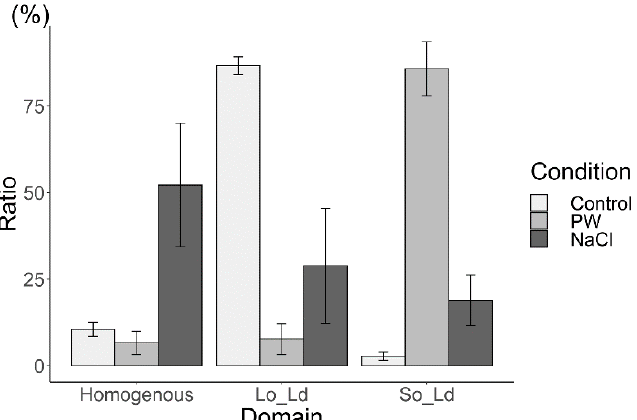
Figure 4. The percentages of phase-separated structures (homogenous, Lo/Ld, and So/Ld in DPPC:DOPC:Chol (40:40:20), Control, bright grey); DPPG:DPPC:DOPC:Chol (15:25:40:20), made in pure water (PW, grey)); and DPPG:DPPC:DOPC:Chol (15:25:40:20) made in a 10 mM sodium chloride solution (NaCl, dark grey), respectively, performed at 20.0 ° C. Condition PW means the number ratio of homogeneous, Lo/Ld, So/Ld liposomes observed in pure water, and condition NaCl means those observed in a 10 mM NaCl solution. Each bar represents the average value of three samples; standard errors are shown as error bars. Abbreviations: DPPC, 1,2-dipalmitoyl- sn -glycero-3-phosphocholine; DOPC, 1,2-dioleoyl- sn -glycero-3-phosphocholine; DPPG, 1,2-dipalmitoyl- sn -glycero-3-phosphoglycerol; Chol, cholesterol; Lo/Ld, liquid-ordered/liquid-disordered; So/Ld, solid-ordered/liquid-disordered.